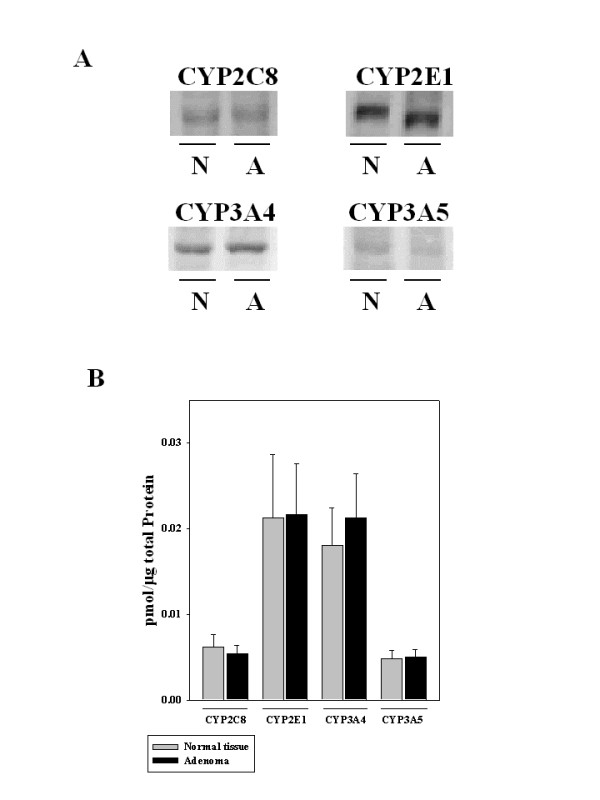
Protein levels of CYP2C8, CYP2E1, CYP3A4, and CYP3A5 in macroscopically normal tissue and in adenoma of patients with colonic adenoma. (A) Representative Western blots of CYP2C8, CYP2E1, CYP3A4, and CYP3A5 in macroscopically normal colon mucosa (= N) and adenoma (= A) of patients with colonic adenomas and (B) quantitative analysis of blots are shown. CYP2E1, CYP3A4, and CYP3A5 protein levels were determined in 25 patients with adenoma. CYP2C8 protein levels were determined in 19 cases. Data are means ± SEM